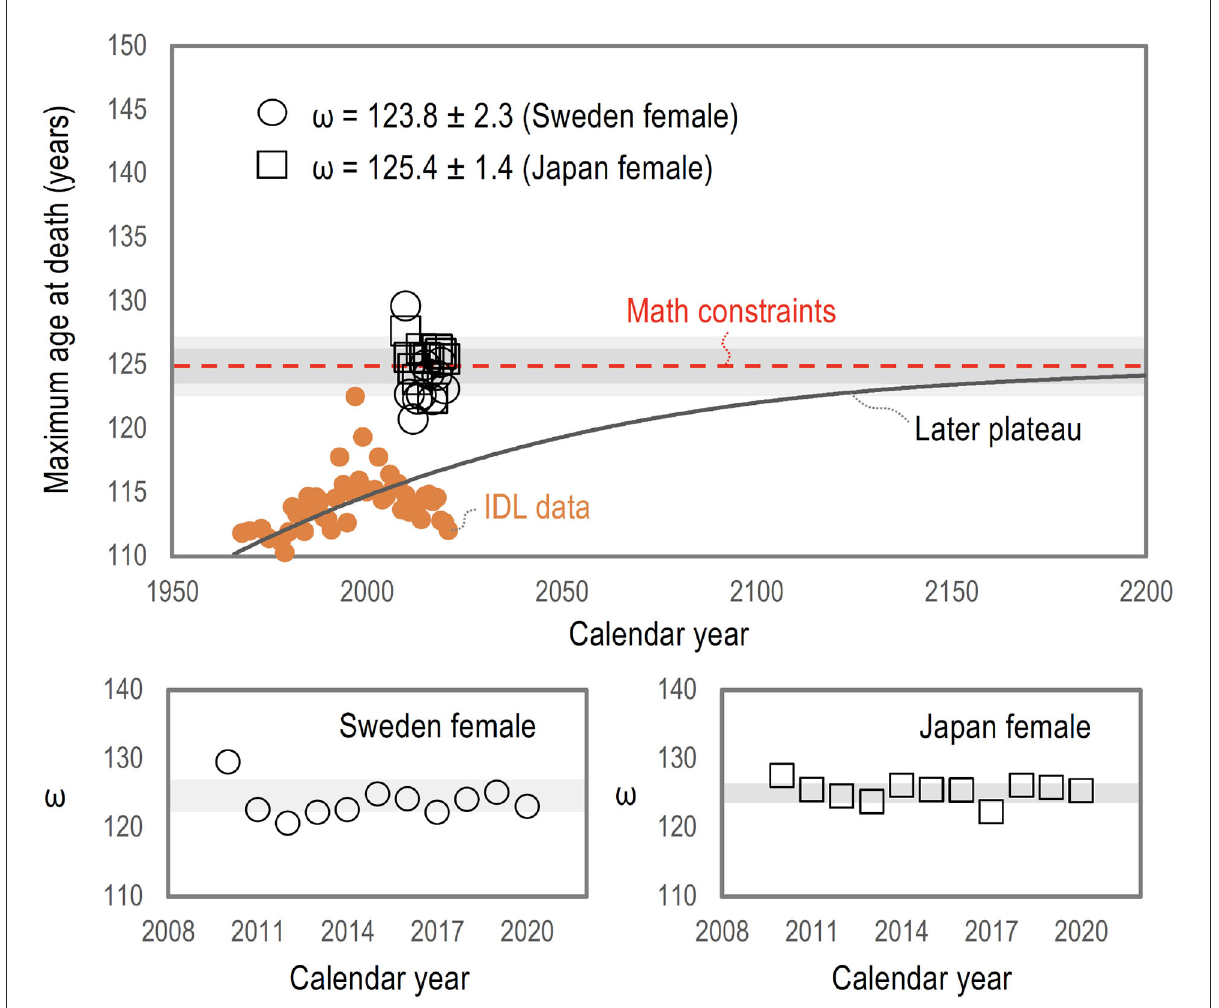
FIGURE3 Possible limits to human lifespan growth. The maximum mathematical lifespans ( ω ) taken from periodic life table data for Sweden females and Japan females between 2010 and 2020 are almost constant as ω = 123.8 ± 2.3 years for Sweden females and ω = 125.4 ± 1.4 years for Japan females ( ± a standard deviation, which is described by a shaded area). The actual survival curve cannot surpass the maximum mathematical lifespan limit, indicating the existence of mathematical constraints around ∼ 125 years (marked by the dashed red line). This consideration is consistent with the later plateau hypothesis of the maximum age at death (taken from Hughes and Hekimi (16), marked by the solid black line) among three possible expectations of the IDL data (dots) for